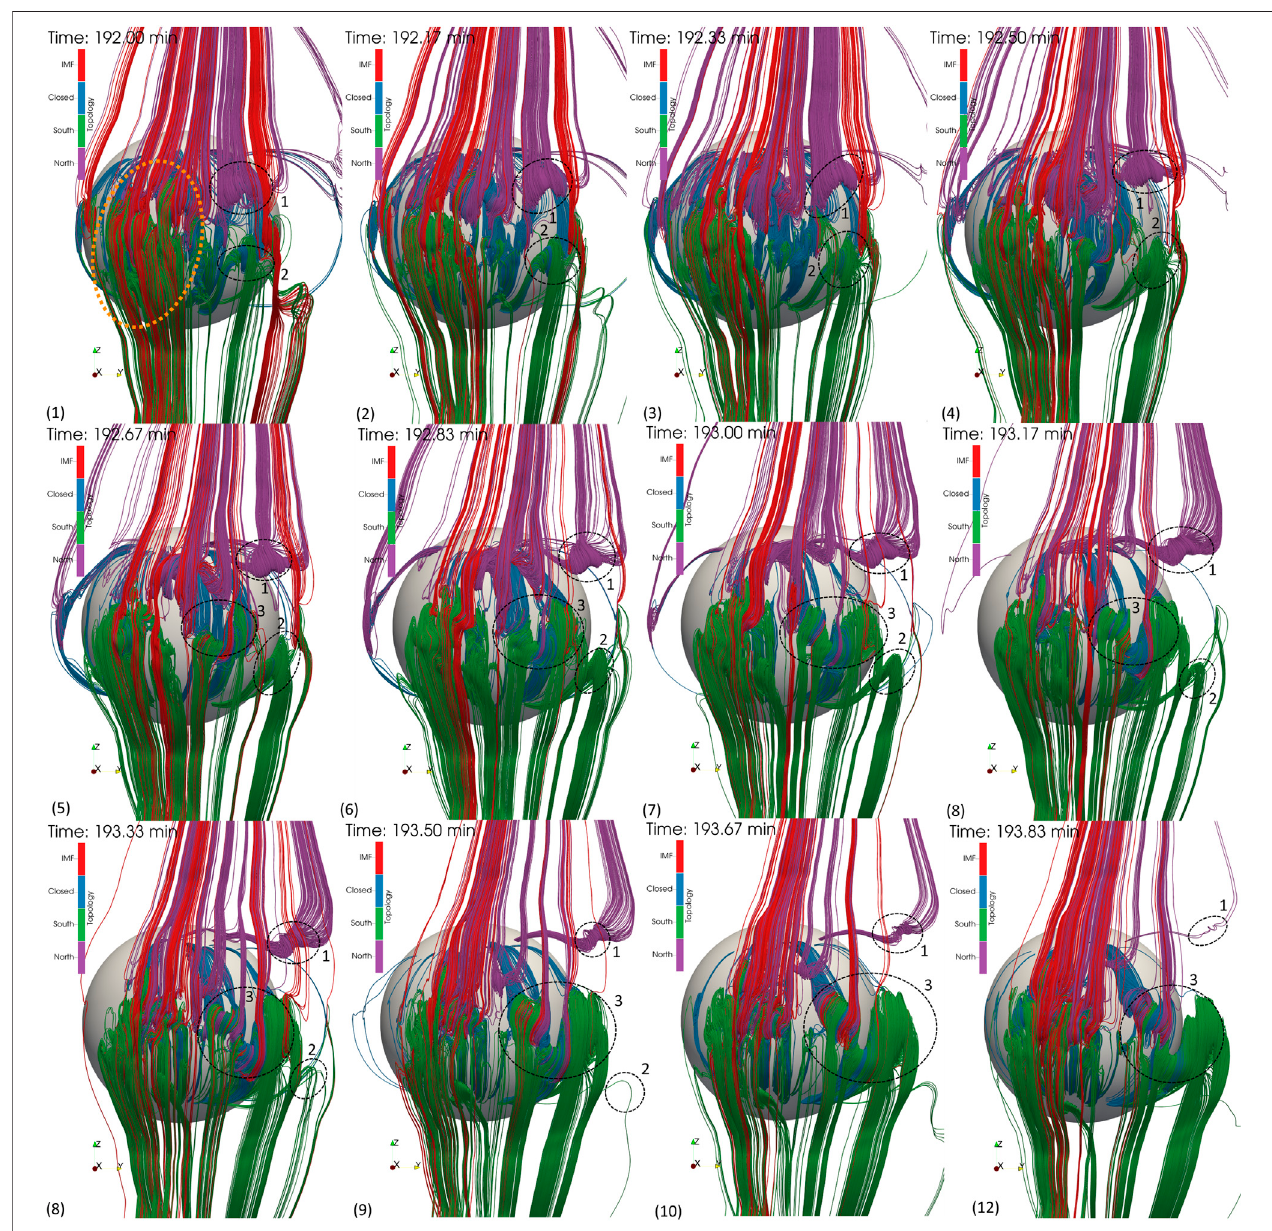
FIGURE6| Flux Ropesgeneratedonthedaysidemagnetopause. Witheach panel,time increases by10s fi eldlines are fi lteredbytheirtotalrotation,showingonly fl ux rope like structures on the magnetopause surface. Behind the fl ux ropes is a6 R E reference sphere. The dayside reconnection region (shown in orange in panel 1), createsacomplicatedmixof fl uxropes.Outofthis,anumberofdistinct fl uxropelikestructuresemerge,asdenotedbytheellipsesmarked1,2and3,whichtraveldown the dusk fl